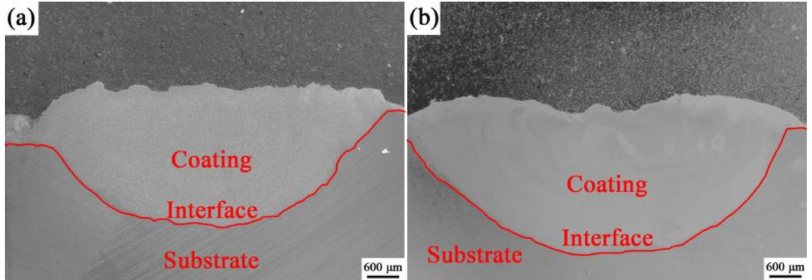
Figure 2. The cross-sectional macro-morphology of coatings: ( a ) without Ta, ( b ) with